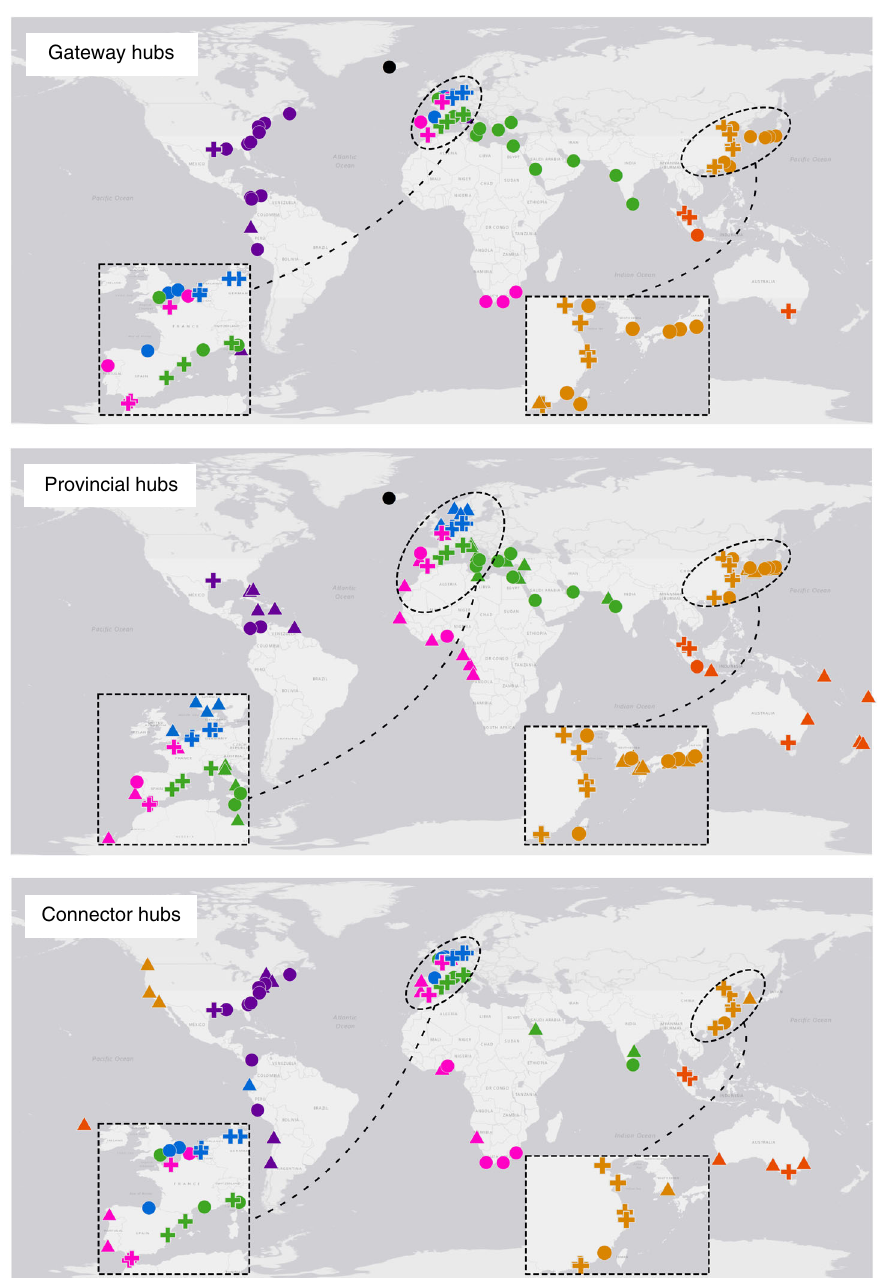
Fig. 5 Geographical distribution of hub ports in the GLSN. Here the three plots show the gateway-hub ports (i.e., ports with B ≥ 1.5), provincial-hub ports (i.e., ports with Z ≥ 1.5), and connector-hub ports (i.e., ports with P ≥ 0.7), respectively. Ports are colored according to modular communities. In each plot, triangles denote ports which have only that particular type of hub role under investigation; circles, ports which have one additional type of hub role; crosses, ports which have all the three types of hub roles. Outside-module degrees ( B ), inside-module degrees ( Z ), and participation coef fi cients ( P ) of the hub ports are reported in the source data. Source data are provided as a Source Data fi